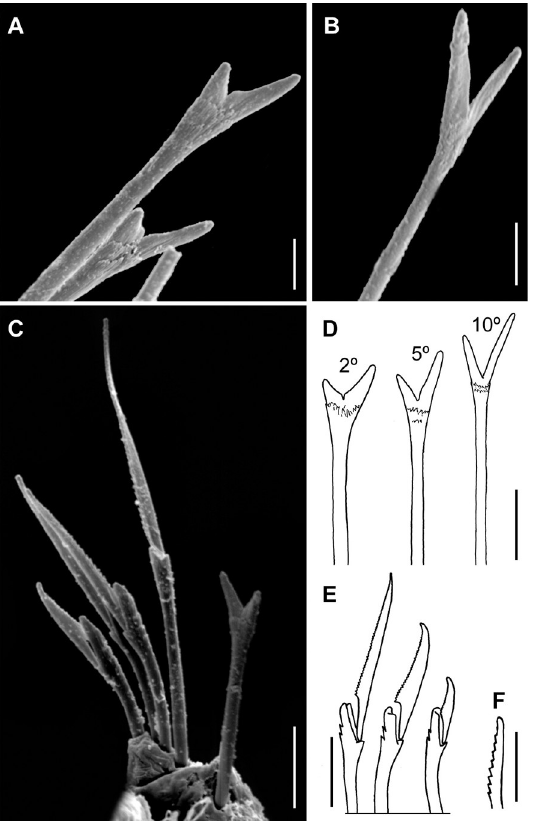
Fig 5. Meiodorvillea minuta (Hartman, 1965), ZUEC-POL. (A) furcate chaeta from anterior region; (B) furcate chaeta from posterior region; (C,E) compound chaetae; (D) morphology of furcate chaeta, from chaetigers 2, 5, and 10; (F) cultriform chaeta. Scales: (A,B) = 5 μ m; (C) = 10 μ m; (D,E,F) = 6.25 μ